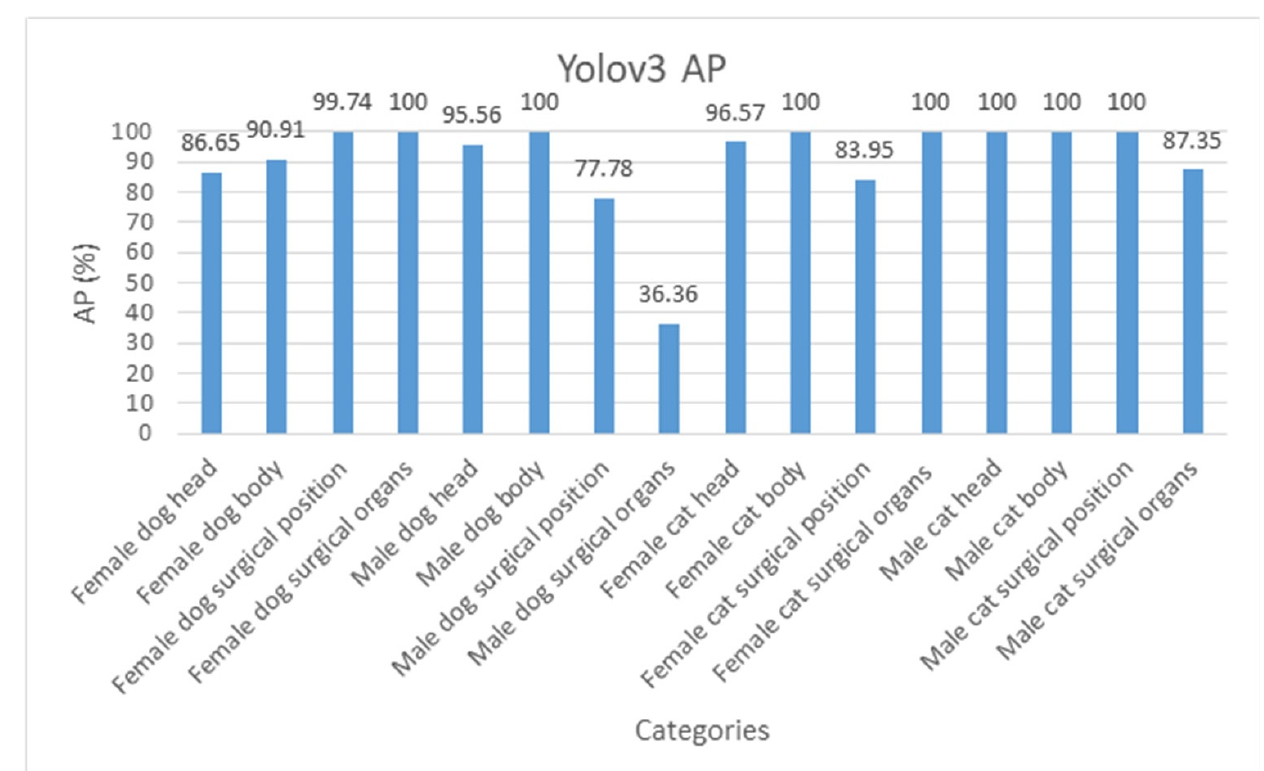
Figure 13. Yolov3 AP of each category.